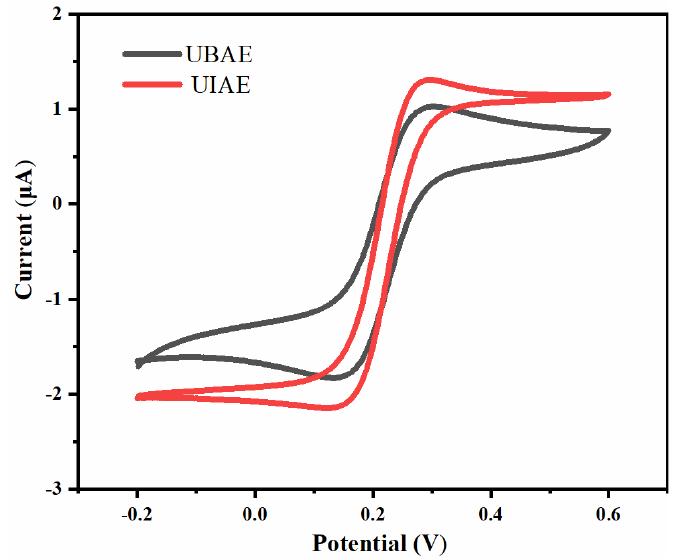
Figure 7. Comparison of electrochemical cyclic voltammetric characteristics between UIAE and UBAE with the spacing-to-width ratio of 13.